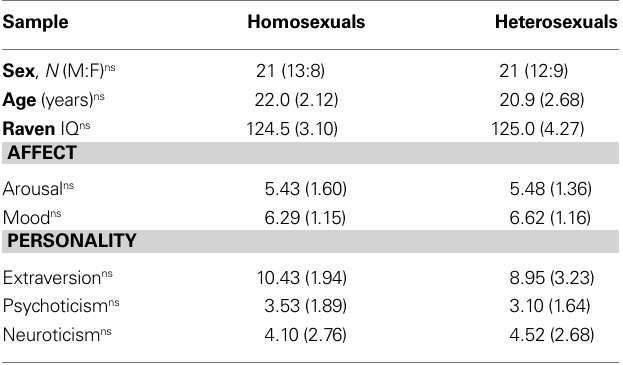
Table 1 | Demographic characteristics of participants.